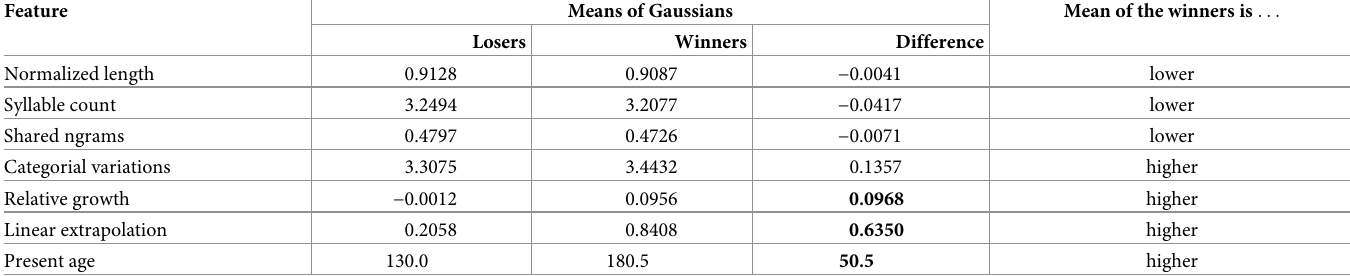
Table 11. Analysis of the naive Bayes models for Test1. The difference column is the mean of the Gaussian of the winners (class 1) minus the mean of the Gaussian of the losers (class 0). Differences that are statistically significant are marked in bold. Significance is measured by a two-tailed unpaired t test with a 95% confidence level. This table omits unique ngrams , which are presented in the next table.